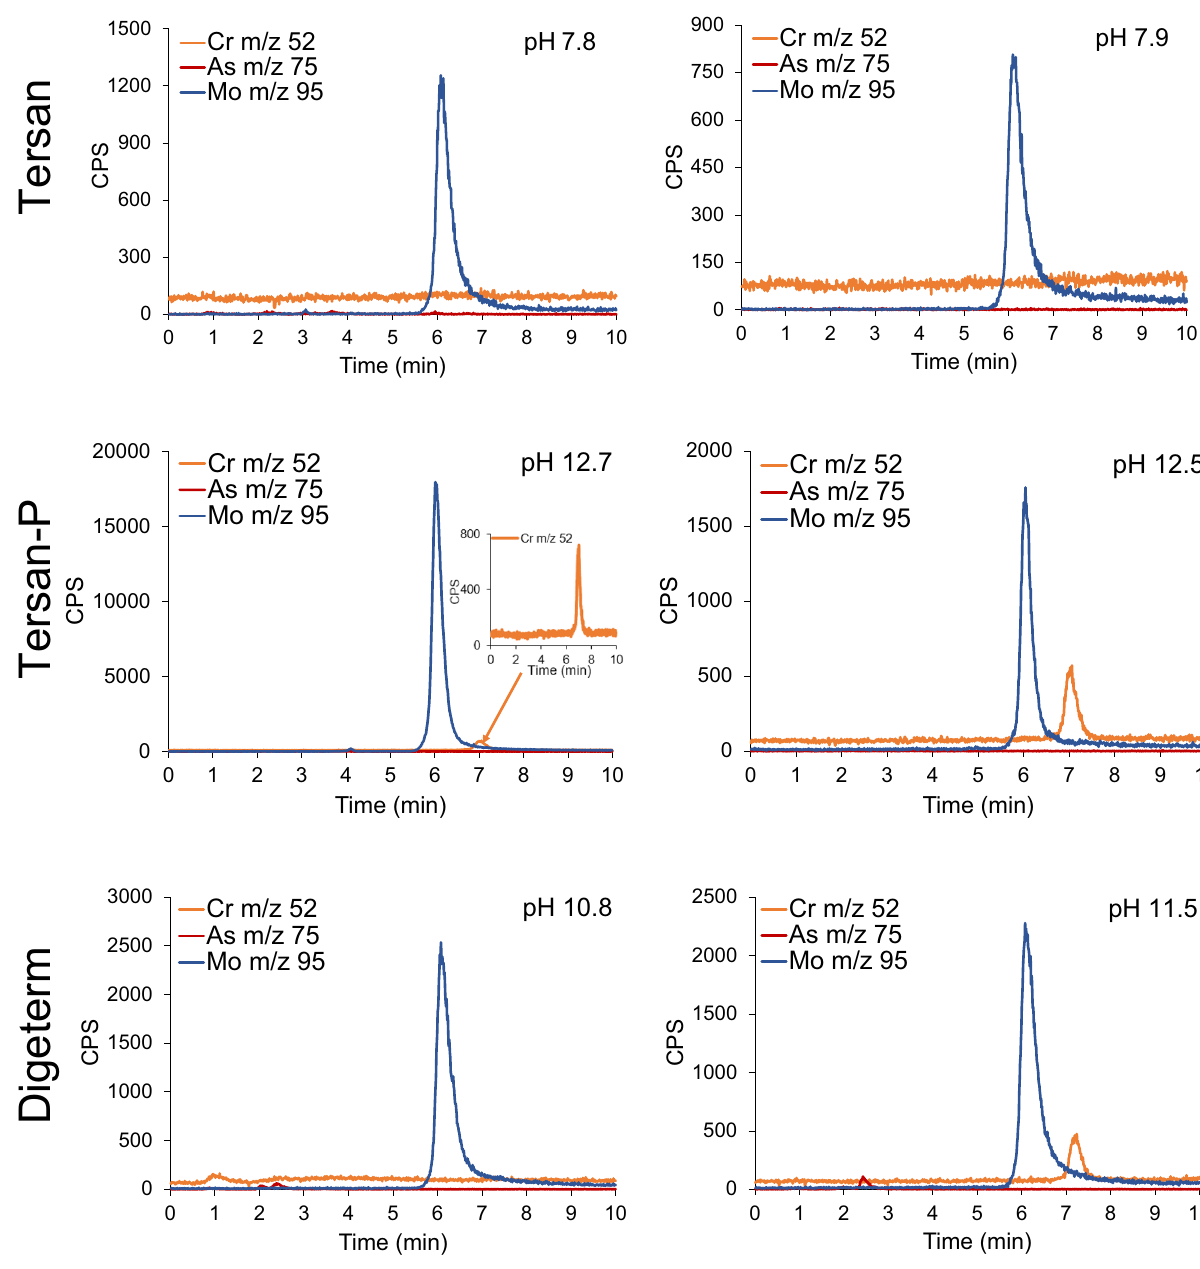
Figure 2. Simultaneous speciation of chromate, molybdate and arsenate in lysimetric water from uncompacted and compacted geotechnical composites, using the HPLC Mono Q column for separation and ICP-MS for detection of separated species at m/z 52, 95 and 75, respectively. In Digeterm composites, sample was diluted 5 times before speciation analysis. Total element concentrations and concentrations of chromate, molybdate and arsenate are provided in Table